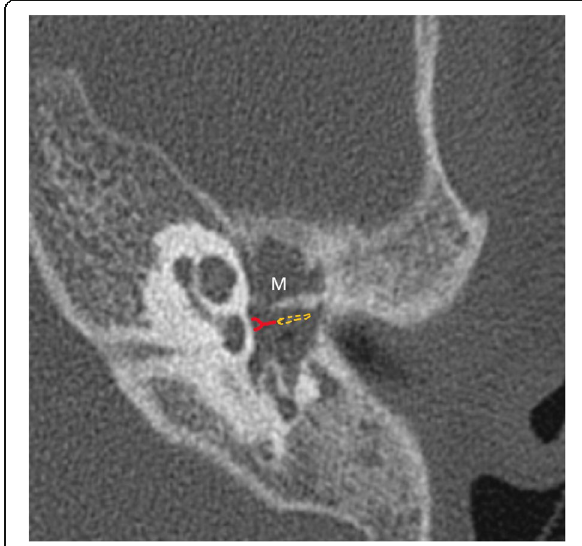
Fig. 8 Axial CT shows soft tissue in the mesotympanum (M) with erosion of long process of incus and stapes which are not visualized in their expected locations. The line diagram illustrates the normal location of stapes (red) and long process of incus